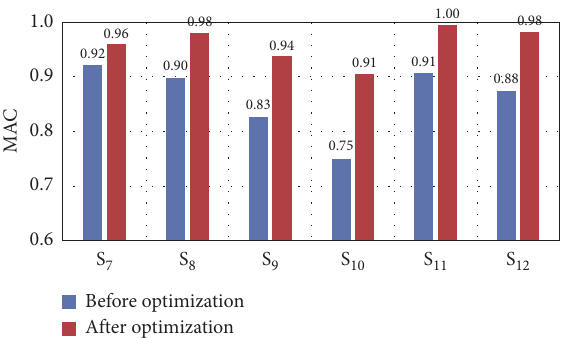
Figure 8: Variation of MAC before and after optimization.